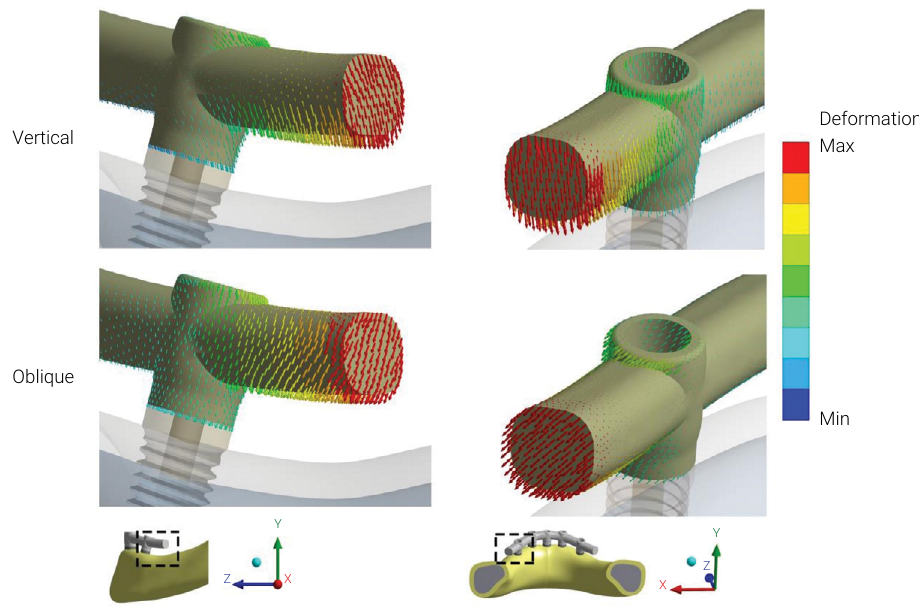
Figure 3. The deformation of the cantilever during the vertical and oblique loading. The vectors indicate the movement direction and the respective